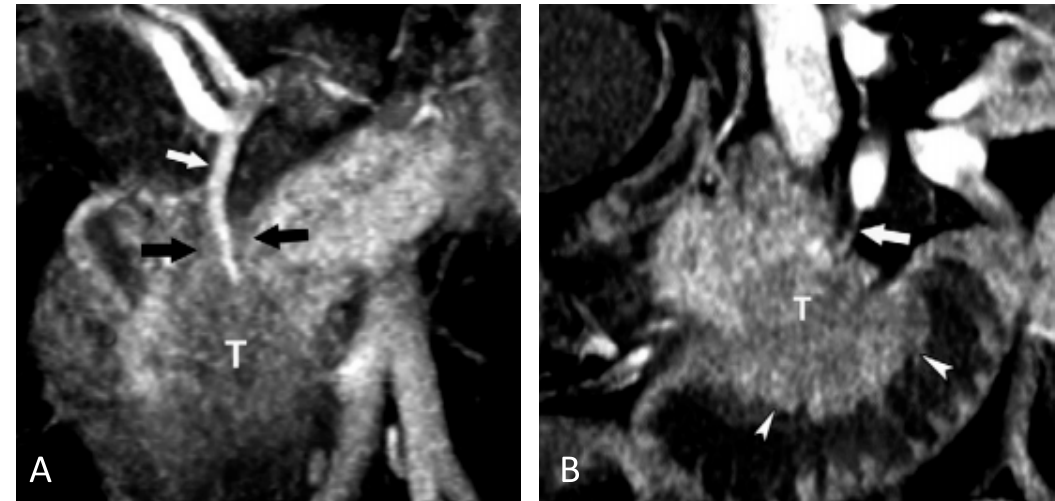
Figure 1. Examples of extrapancreatic perineural invasion and duodenal invation. ( A ) Pancreatic head mass (T) encasing the gastroduodenal artery (GDA) (white arrow) show as the perivascular tissue (black arrow) along the anterior nerve plexus. ( B ) Pancreatic head mass (T) invading the duodenal wall (arrowhead), but sparing the posterior-inferior pancreaticoduodenal artery (arrow). Reproduced with permission from [53].